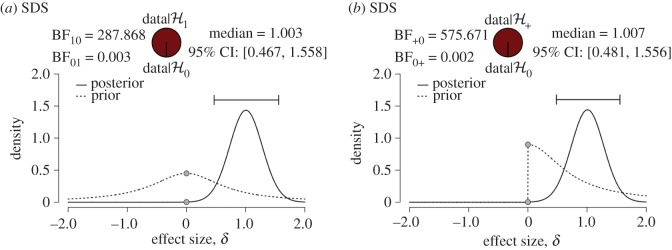
JASP output for the t-test example featuring the first replication study reported in IJzerman et al. [33]. Both panels show the prior and posterior distributions for effect size, the posterior median, the central 95% credible interval and the Bayes factor. (a) The results for the unrestricted hypothesis H1 and (b) the results from the directional hypothesis H+.